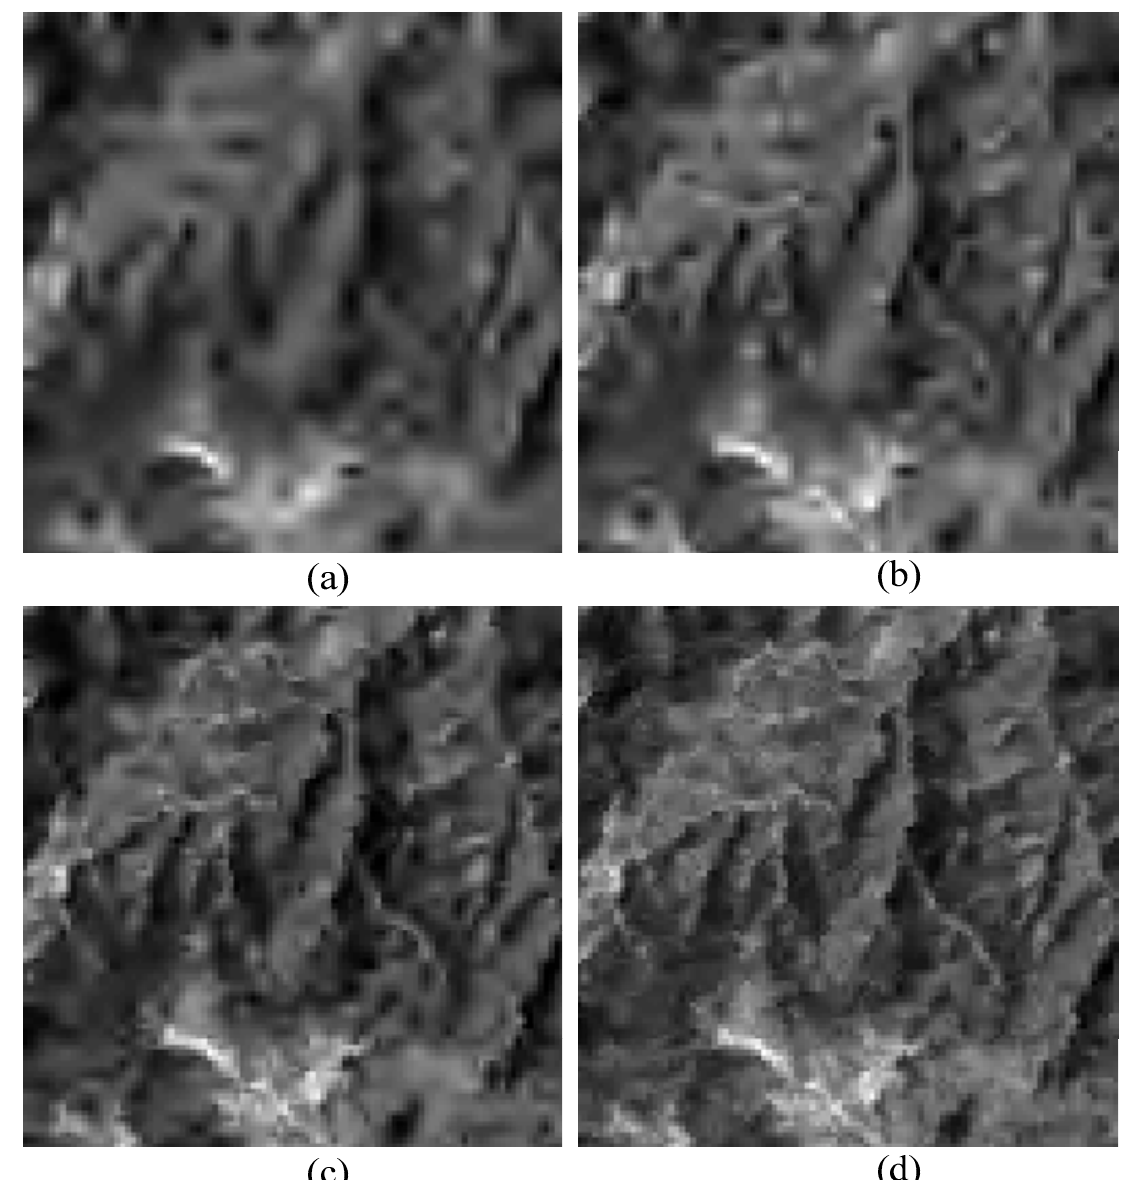
Figure 6. Reconstructed multispectral image at different bit-rates: ( a ) 0.25 bpp; ( b ) 0.5 bpp; ( c ) 1.0 bpp; ( d ) 2.0 bpp; and ( e ) original bands.